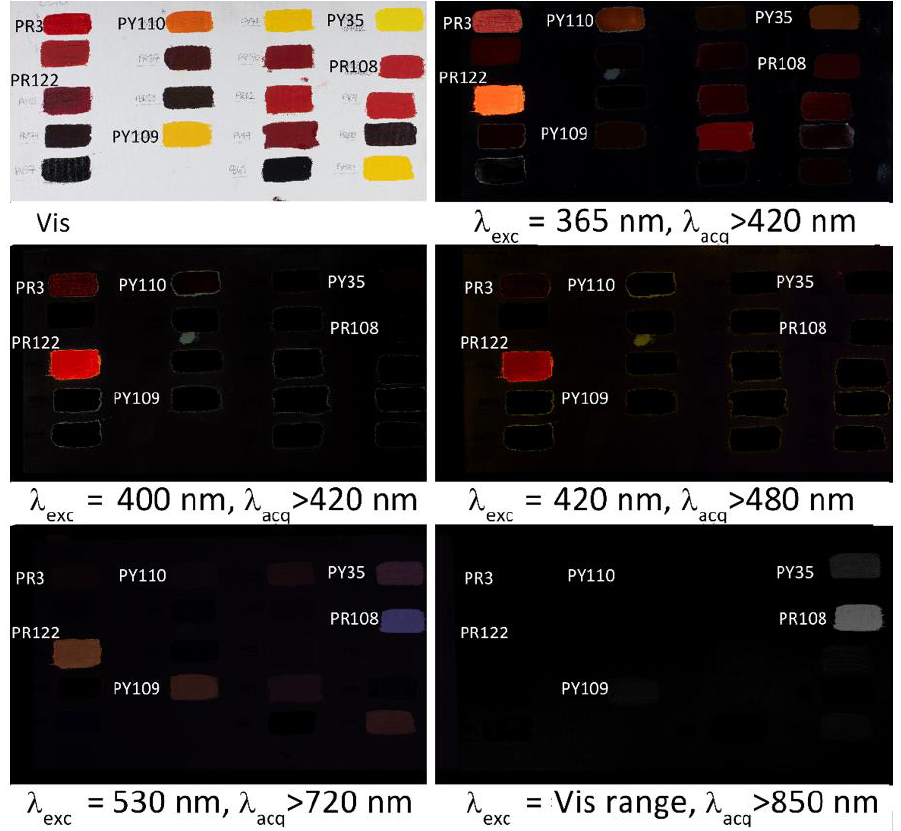
Figure 7. Multiwavelength fluorescence images obtained using UV and Vis excitation, showing the differences in colour and intensity of the emissions of some mock-up paint samples on canvas obtained from synthetic organic pigments mixed with linseed oil.